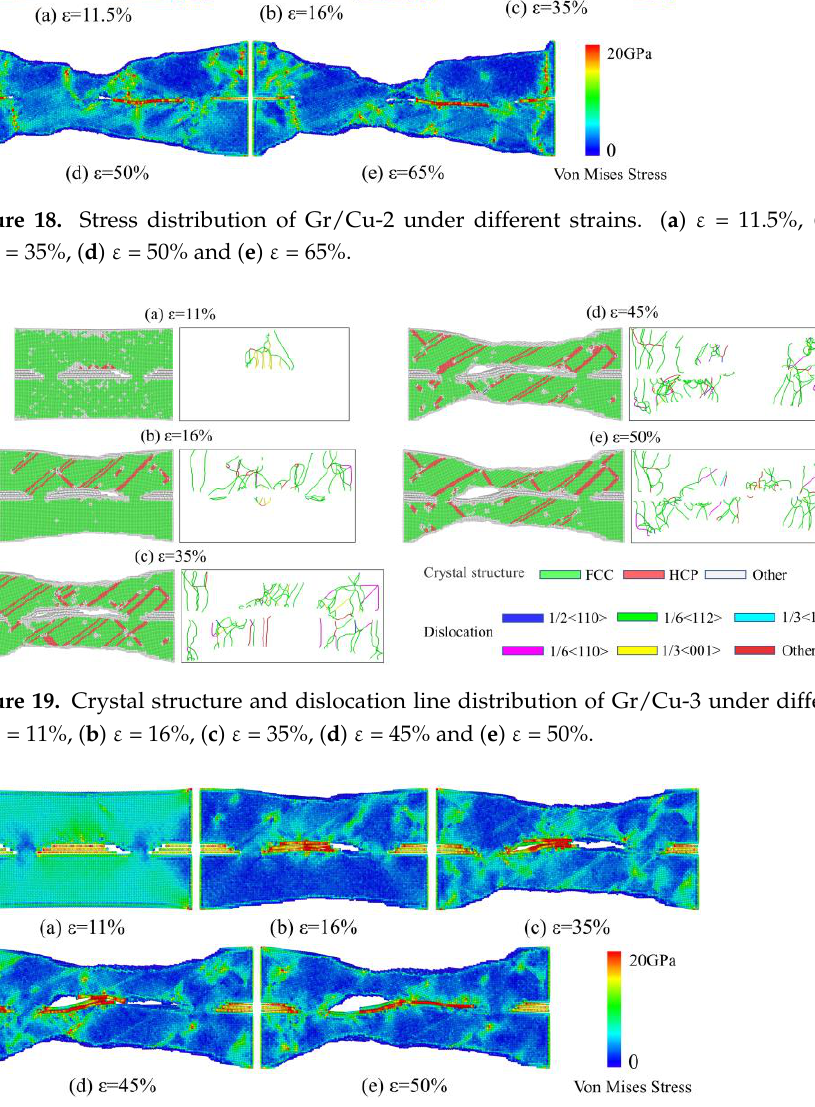
Figure 20. Stress distribution of Gr/Cu-3 under different strains. ( a ) ε = 11%, ( b ) ε = 16%, ( c ) ε = 35%, ( d ) ε = 45% and ( e ) ε =